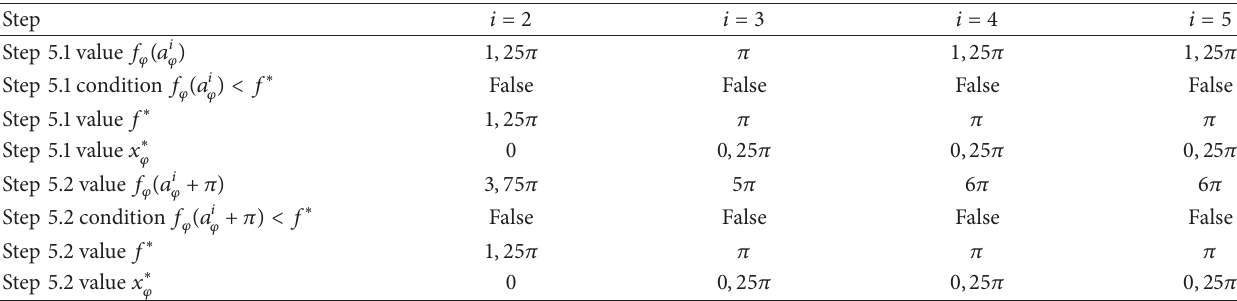
Table 2: Solution (Steps